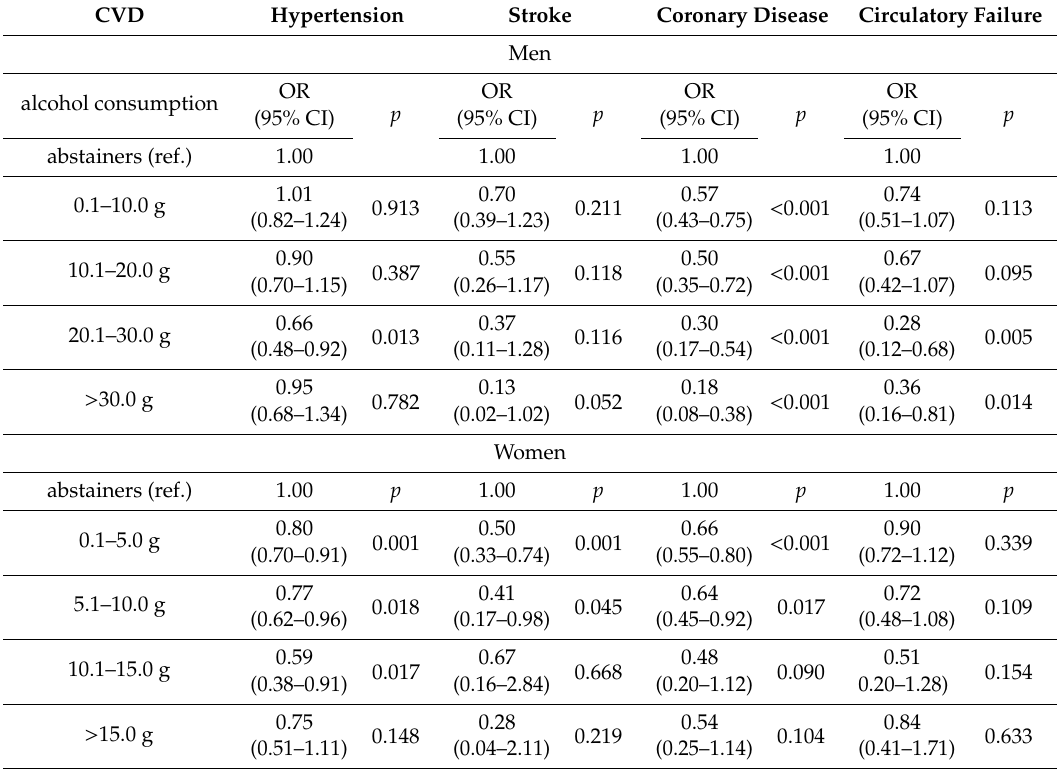
Table 2. Odds ratios and 95% confidence intervals for cardiovascular diseases adjusted for age, marital status, education, smoking, co ff ee consumption, physical activity, BMI, dyslipidemia, statin use, type 2 diabetes, and high fasting glucose or hyperglycemia